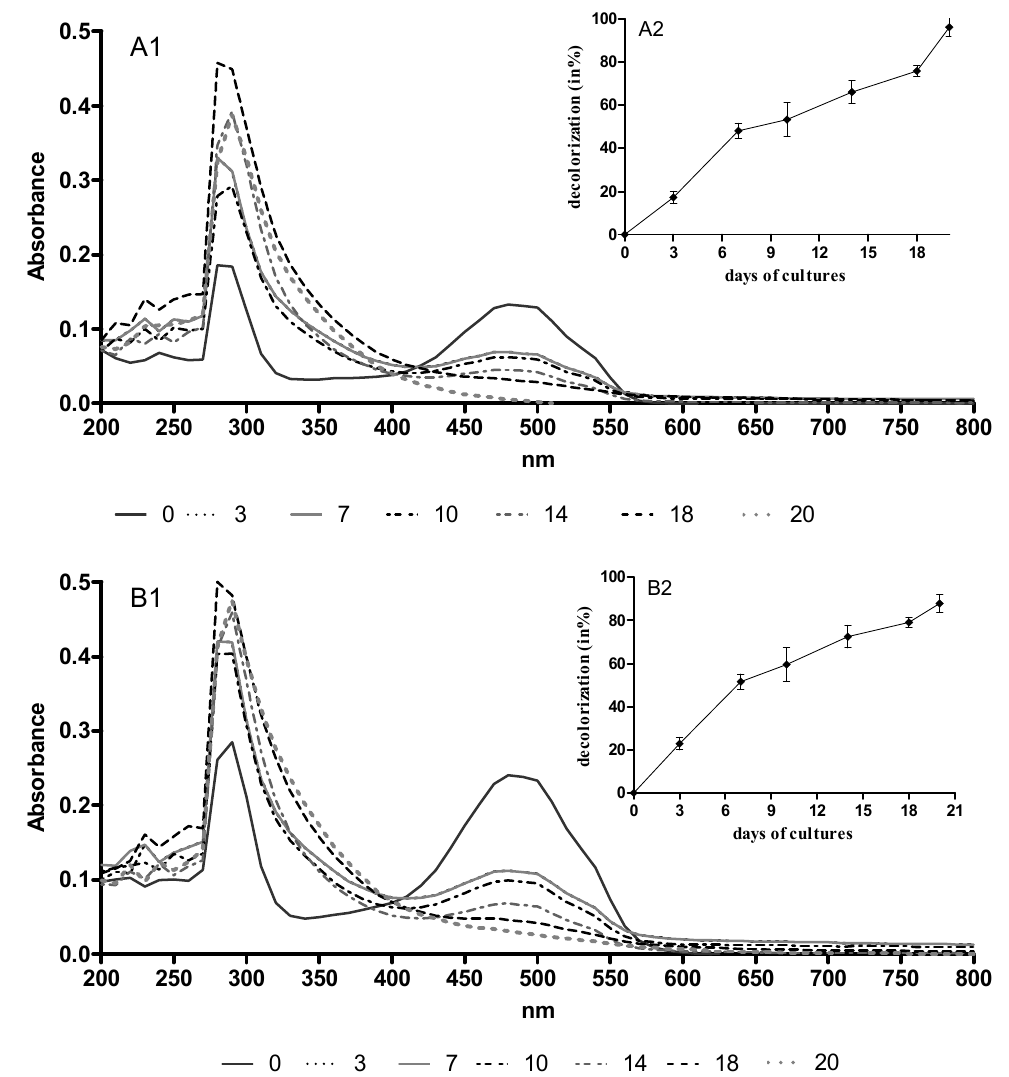
Figure 1. UV-visible spectra (1) and decolorization degree (2) of DNR ( A ) and DOX ( B ) before and during cultures of B. adusta CCBAS 930.